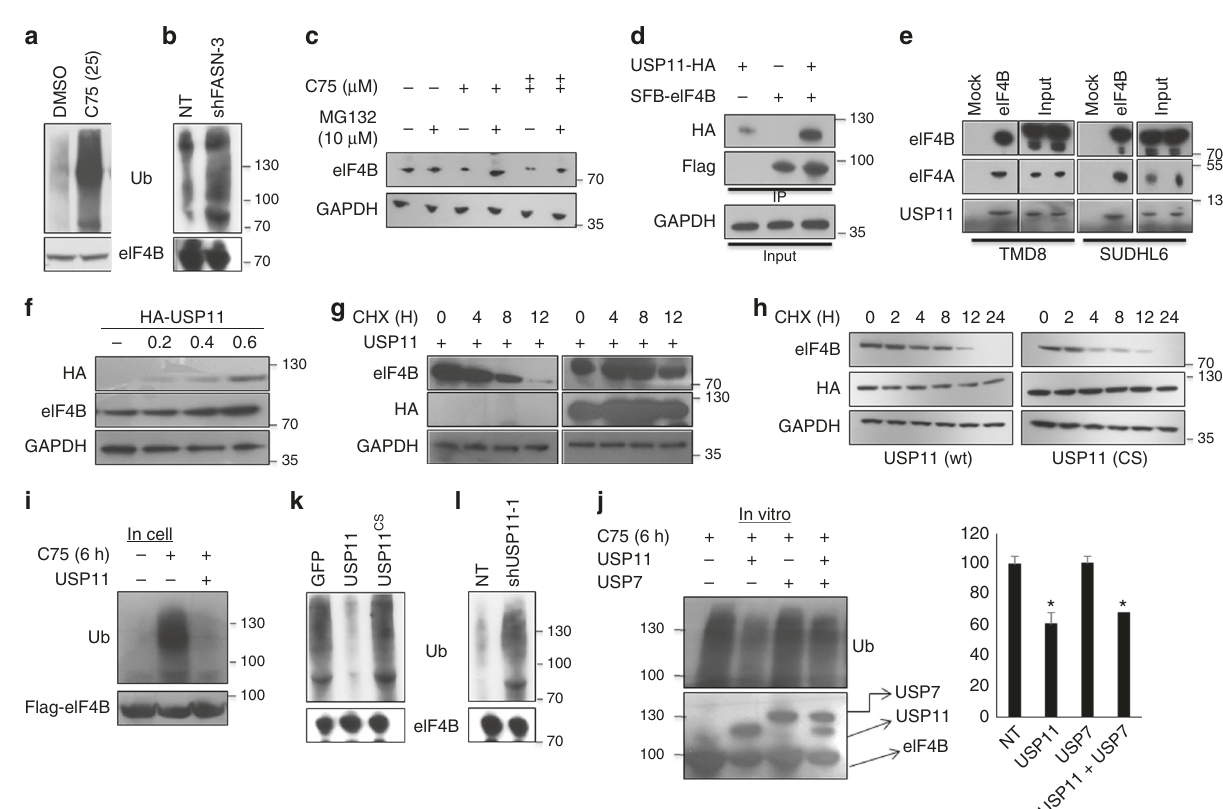
Fig. 4 USP11 deubiquitinates and stabilizes eIF4B. a SUDHL2 was treated with C75 (25 µ M) for 6 h followed by lysis and immunoprecipitation with eIF4B. Lysates were probed with the indicated antibodies. b HLY1 cells were transiently infected with shRNA against FASN (sh-FASN3) and lysed after 48 h of infection followed by immunoprecipitation with eIF4B. Lysates were probed for the indicated antibodies. c SUDHL2 was treated with C75 (indicated concentration, + : 10 µ M, ++ : 25 µ M) for 14 h followed by treatment with MG132 (10 µ M) for 4 h. Lysates were probed with the indicated antibodies. d 293T cells were transfected with SFB-eIF4B and/or USP11-HA. eIF4B was enriched by pulling down using streptavidin beads and probed with anti-HA antibodies for detection of USP11. eIF4B enrichment was con fi rmed by probing with anti- fl ag antibody. e Lysates from TMD8 and SUDHL4 were immunoprecipitated with eIF4B antibody and probed for USP11. f 293T cells were transfected with increasing concentration of USP11 and levels of endogenous IF4B was con fi rmed by immunoblotting. g , h 293T cells were transfected with either GFP or USP11 ( f ) and USP11 or USP11 cs ( g ) and treated with CHX in increasing time point and probed for indicated antibodies. i 293T cells were transfected with SFB-eIF4B alone or in combination with USP11 and treated with C75 (25 µ M) for 6 h. Post lysis, eIF4B was enriched using streptavidin beads and levels of ubiquitin were detected using speci fi c antibody. j TMD8 cells stably expressing the indicated genes were treated with C75 for 12 h followed by lysis and immunoprecipitation with eIF4B. Lysates were probed with the indicated antibodies. k SUDHL6 transiently infected with shRNA against USP11 (sh-USP11-1) and lysed after 48 h of infection followed by immunoprecipitation with eIF4B. Lysates were probed for the indicated antibodies. l In vitro deubiquitination assay of eIF4B. Polyubiquitinated eIF4B, fl ag- tagged USP11, and USP7 were enriched from 293T (see the experimental procedure for details) and were incubated with buffered conditions for deubiquitination. Post reaction lysates were probed with the indicated antibodies. Bar diagram represents the densitometric analysis of the ubiquitin signals. Values were normalized with corresponding fl ag signals and were represented as mean ± SD ( n = 3). Statistical analysis was performed using Students t -test, * p < 0.05, vs. NT (control)